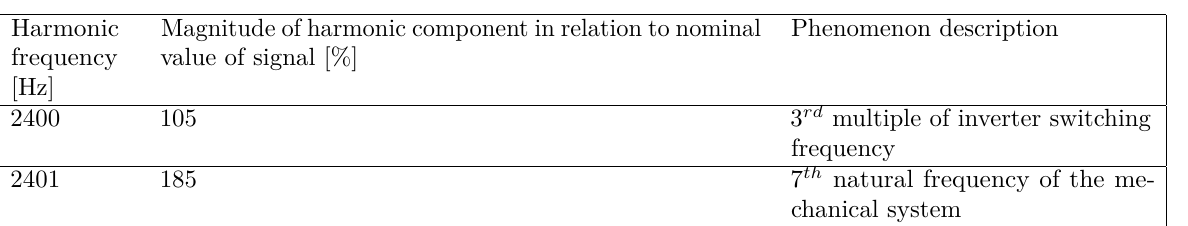
Table 2. Harmonic frequencies of the gearwheel accelerating torque – overview and description.